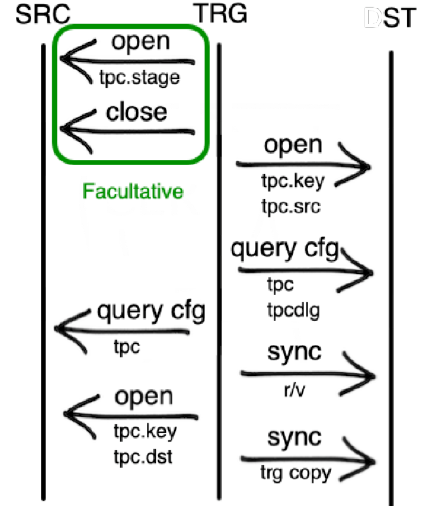
Figure 1 . Event sequence in the XRootD TPC protocol. TRG is the client that triggers the TPC. The CGI key tpc.dlg will be set to zero to indicate that there will be no credential delegation. The last two steps between SRC and TRG establish a rendezvous point. The tpc.key is used to pass the rendezvous key.